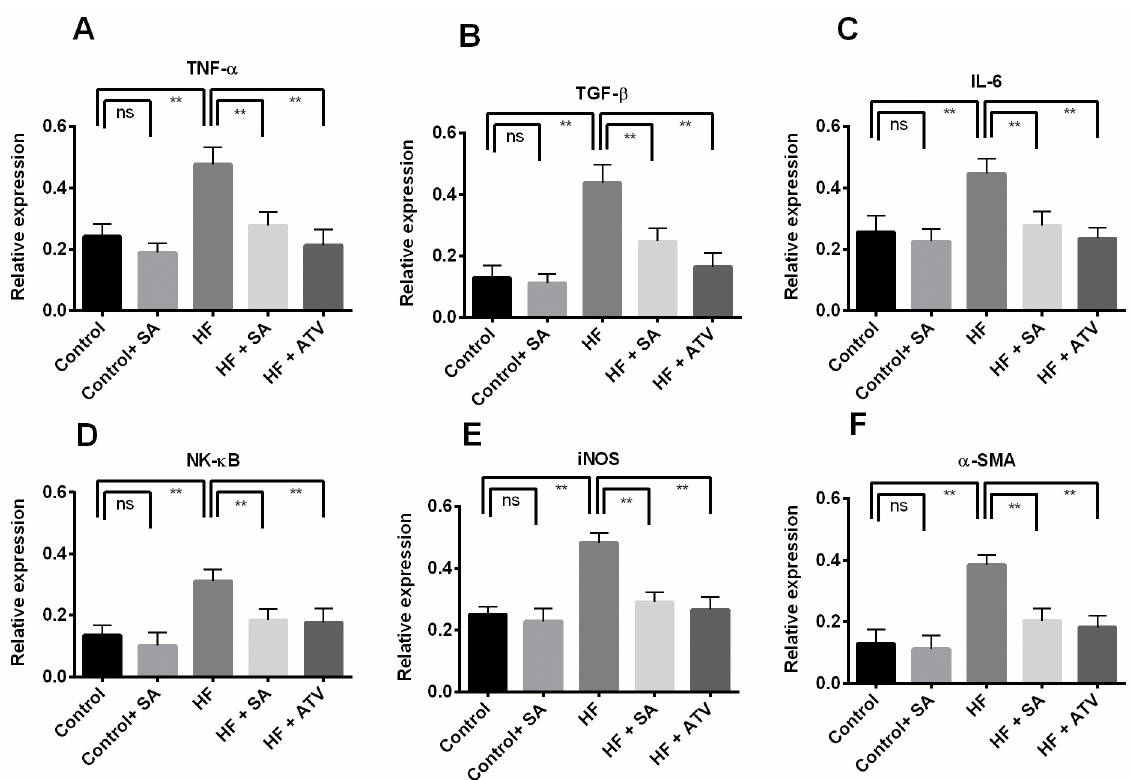
Fig 8. Effect of Senna alexandrina leaf powder supplementation on inflammatory genes expression in liver of high fat diet induced obese rats. Here, A. Tumor necrosis factor alpha (TNF- α ); B. Transforming growth factor beta (TGF- β ); C. Interleukin-6 (IL-6); D. Nuclear factor kappa B (NK- κ B); E. Inducible nitric oxide synthase (iNOS); F. Alpha smooth muscle actin ( α -SMA). Values are presented as mean ± SD, n = 6. One-way ANOVA followed by Tukey’s multiple comparisons test was done for statistical comparison. �� represents p � 0.001.